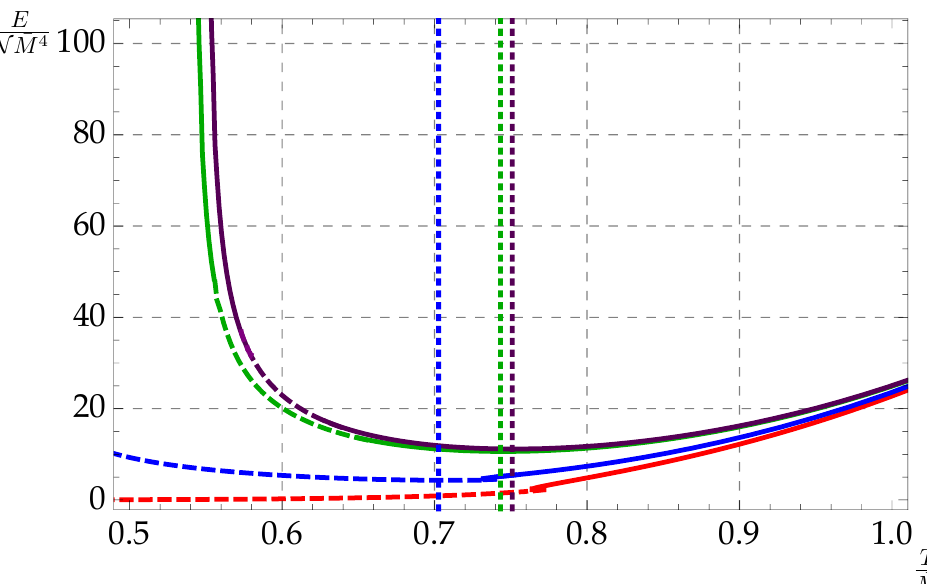
Figure 12 . Energy density E= N (cid:22) M 4 as a function of T= (cid:22) M . Red, blue, green, and purple curves (bottom to top) correspond to b= (cid:22) M 2 = f 0 ; 2 ; 3 : 3 ; 3 : 4 g respectively. The dashed segments correspond to Minkowski embeddings, while the continuous segments correspond to black hole embeddings. The dotted vertical lines denote the temperature at which the speci(cid:12)c heat becomes negative for each magnetic (cid:12)eld other than zero ( b= (cid:22) M 2 = f 2 ; 3 : 3 ; 3 : 4 g from left to right). The (cid:12)nite term is (cid:12)xed at C 2 =